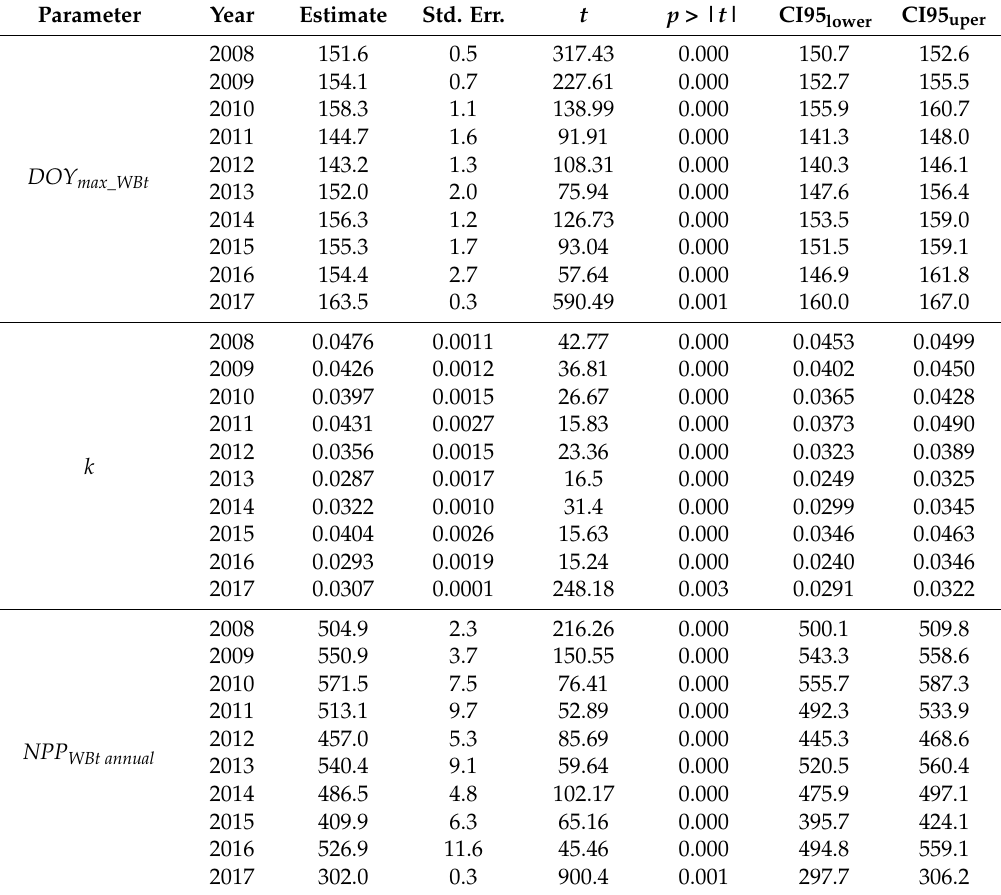
Table A4. Parameters of the NPP WBt fit with Equation